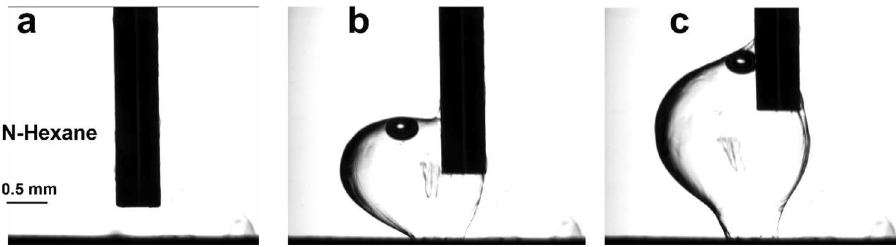
Figure 2. 3D printed objects: case 1. Optical images of the formation of 2D nanosheets from C9 molecules at water-hexane interface. ( a ) Approaching the nozzle to the substrate, ( b ) injection of the C9-dithiol in hexane solution, ( c ) injection of the C9-dithiol in hexane solution and pulling up the nozzle at the same